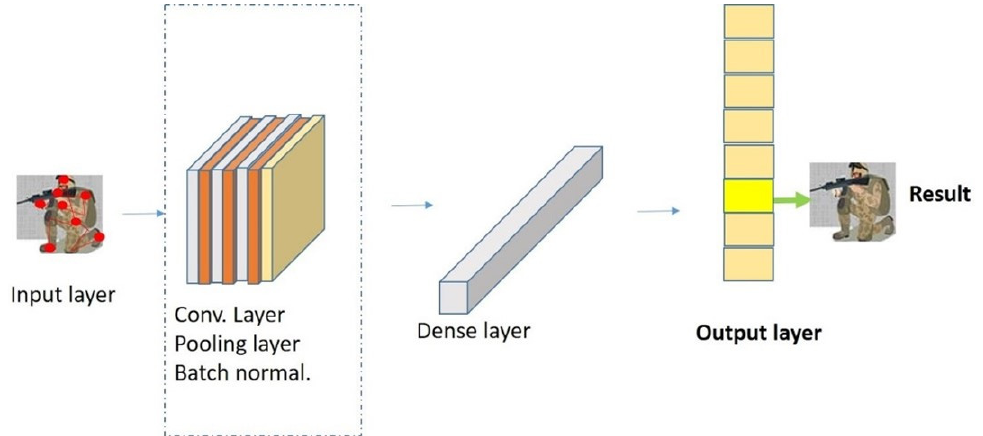
Figure 8. The design of the CNN classifier.